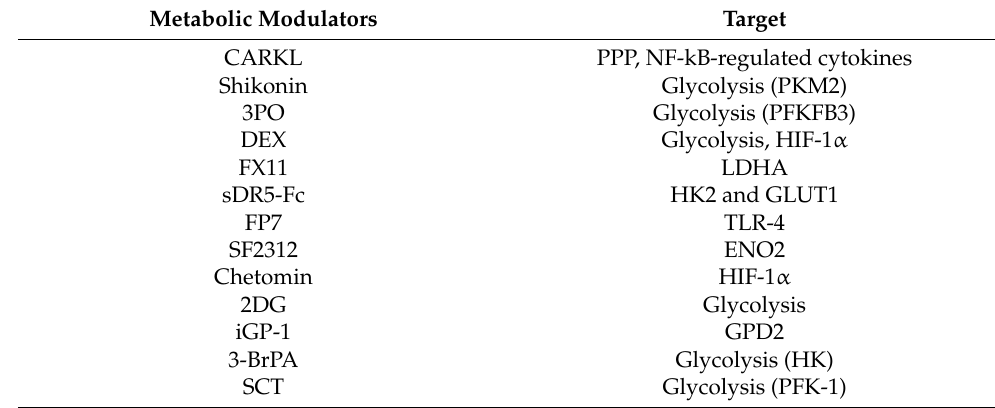
Table 1. A brief description of the molecules that affect metabolic reprogramming and the major metabolic pathways and/or enzymes that are affected by those